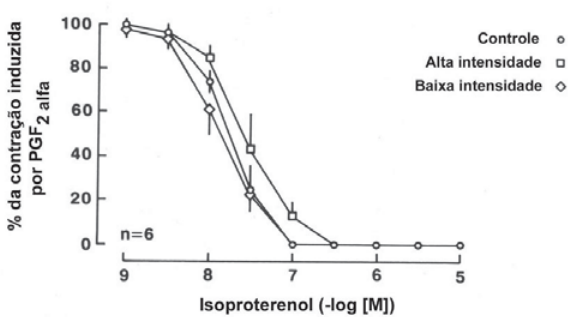
Fig. 7 - Relaxamento independente do endotélio induzido por isoproterenol em artérias coronárias caninas. As artérias foram expostas à baixa ou alta intensidade de energia ultra-sônica e contraídas com prostaglandina F (PGF ). Quando a contração 2 α 2 α induzida pela PGF estabilizou, as artérias foram submetidas a 2 α concentrações crescentes de isoproterenol. Os dados estão apresentados como médias ± erro padrão médio e não se observaram diferenças estatisticamente significantes (n = 6,